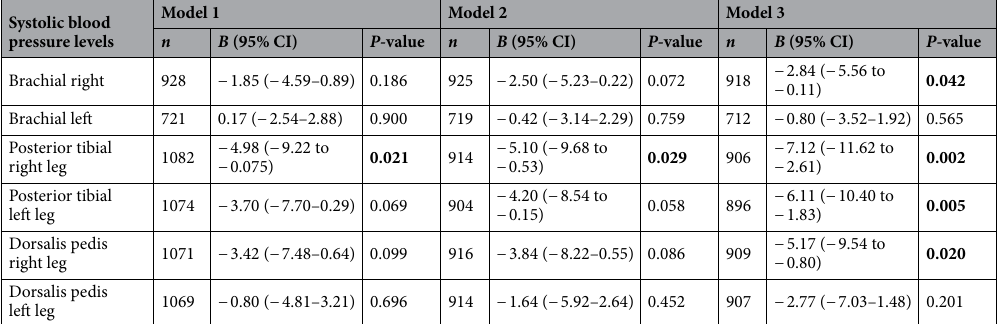
Table 4. Associations between blood pressures and cardiovascular disease status. Adjusted model: Ankle blood pressure is negatively associated with cardiovascular disease status. Model 1: adjusted to age and sex; Model 2: adjusted age, sex, BMI, waist height ratio, ethnicity; Model 3: adjusted age, sex, BMI, waist height ratio and European and South Asian